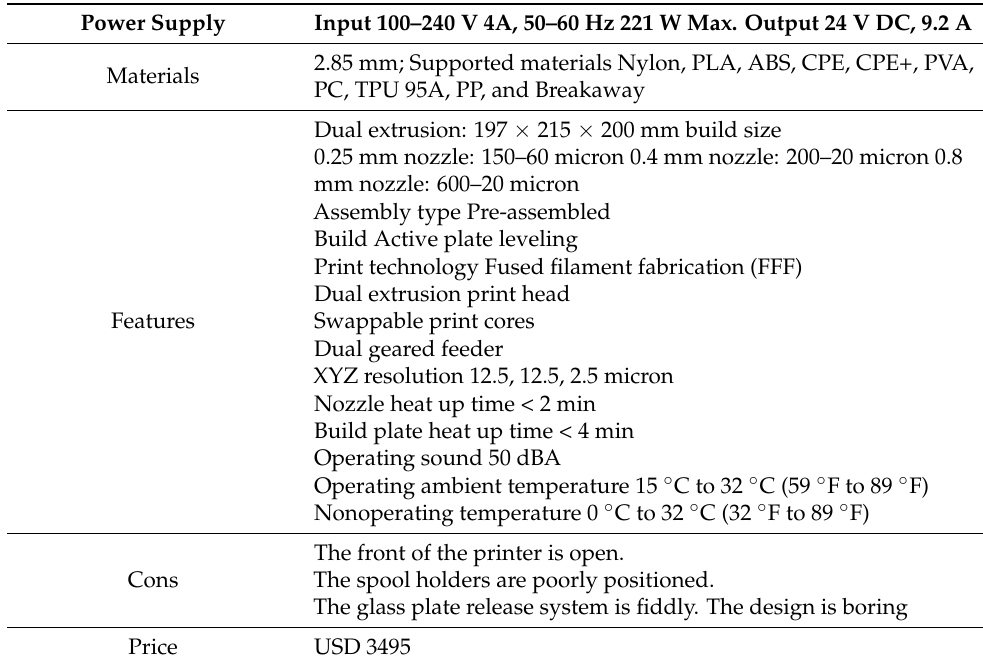
Table 10. Descriptions of Makerbot Ultimaker 3 Desktop 3D